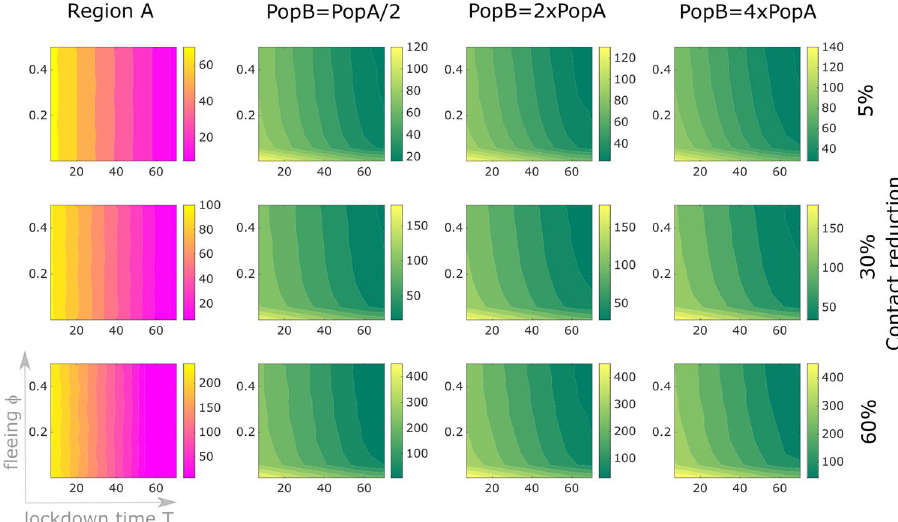
Figure 4. How long should control measures be in place? An initial outbreak starts off with 20 cases and two deaths in region A (population 25 million) which is then locked at time T (horizontal axes indicate days after the initial reporting) and lockdown-induced migration (vertical axes) occurs. In both regions, at the time of lockdown, control measures are applied to restrict contacts by 5% (first row), 30% (second row) or 60% (third row), and maintained for 7 days after the peak in the daily incidence in the respective region is reached. Color codes represent the duration in days of the control period in region A (first column) and region B (second to fourth columns), also depending on the population size in region B (being half, twice or four times the population in region